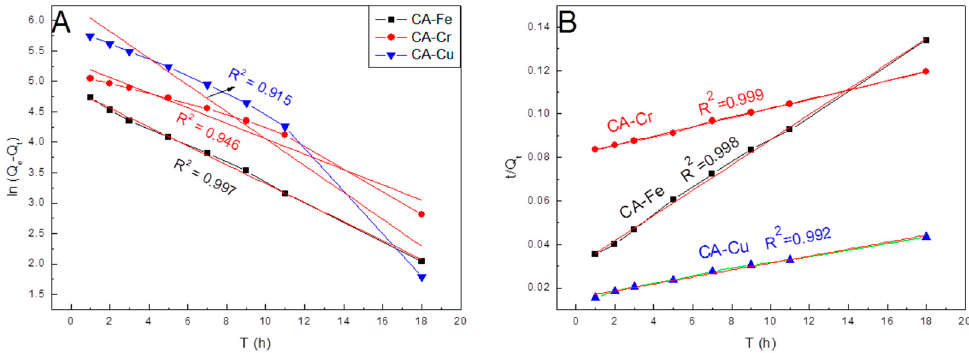
Figure 1 . ( A ) Pseudo-first-order kinetic model and ( B ) pseudo-second-order kinetic model.